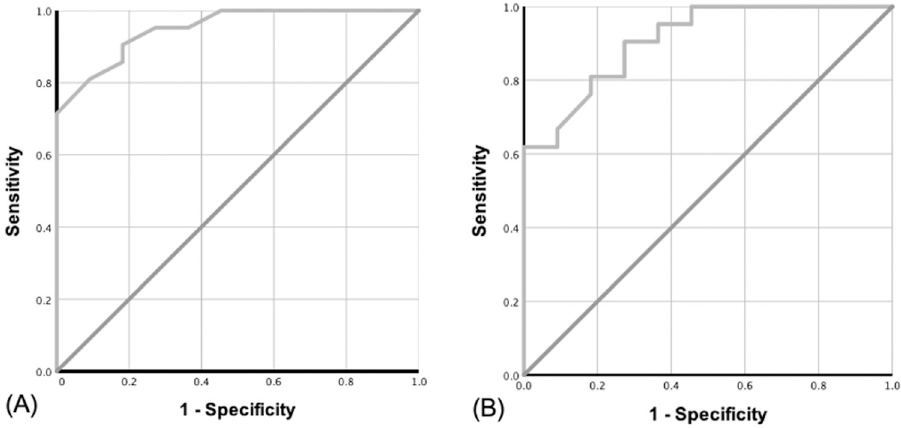
Fig 2. The predictive value of WC (A) and BMI (B) to predict visceral obesity (VAT � 100 cm 2 ) are presented in ROC. The AUC of the WC ROC is 0.95 while the AUC of BMI ROC is